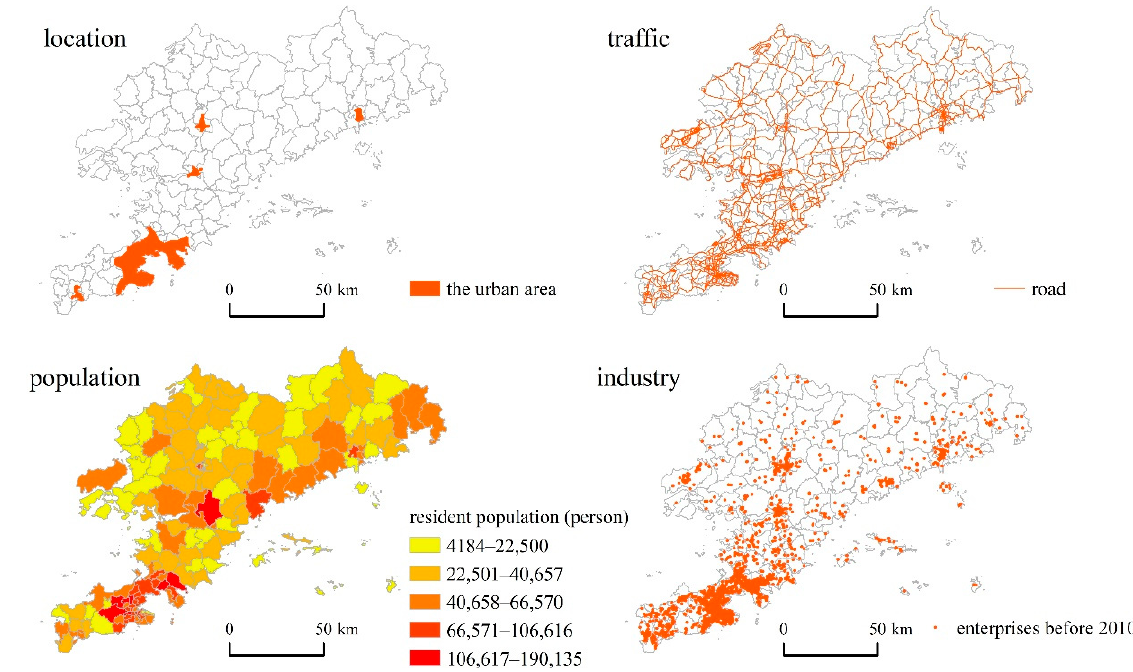
Figure 3 . Reference factors rely on basic data . Figure 3. Reference factors rely on basic